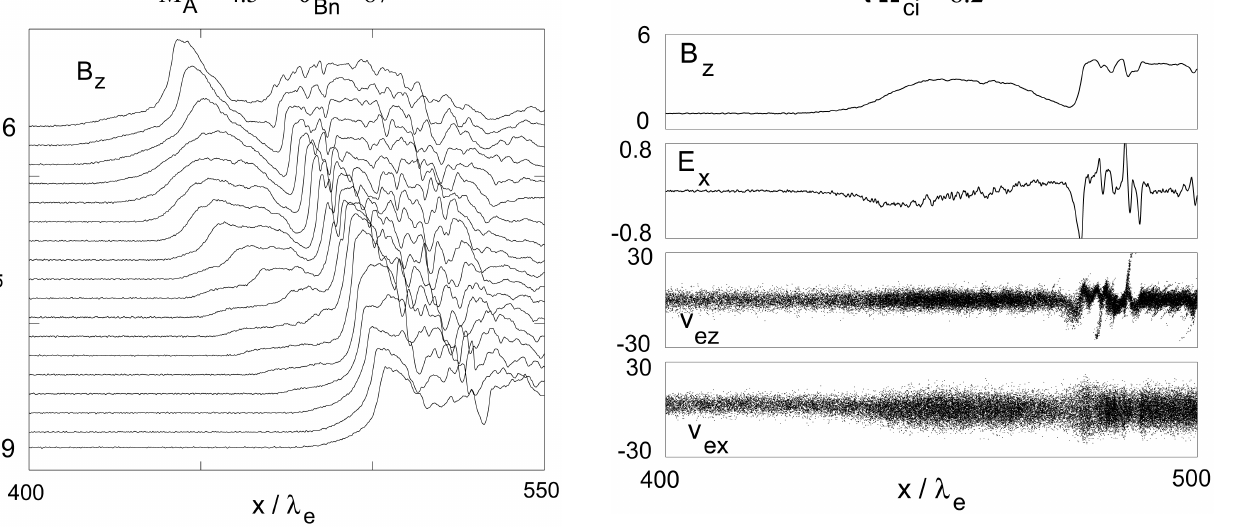
Fig. 5. From top to bottom: magnetic field B z component, electric field component E x , and electron v ez and v ex phase space versus shock normal direction x